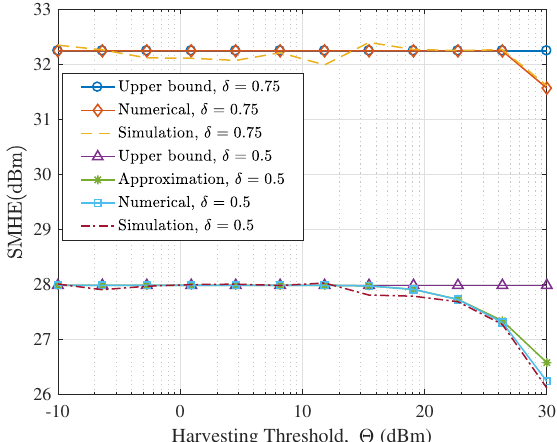
Figure 8. Spatial mean harvestable energy for LSWN-noIC with λ t = 0.1, α = 4, η a = 1 and P et = 30